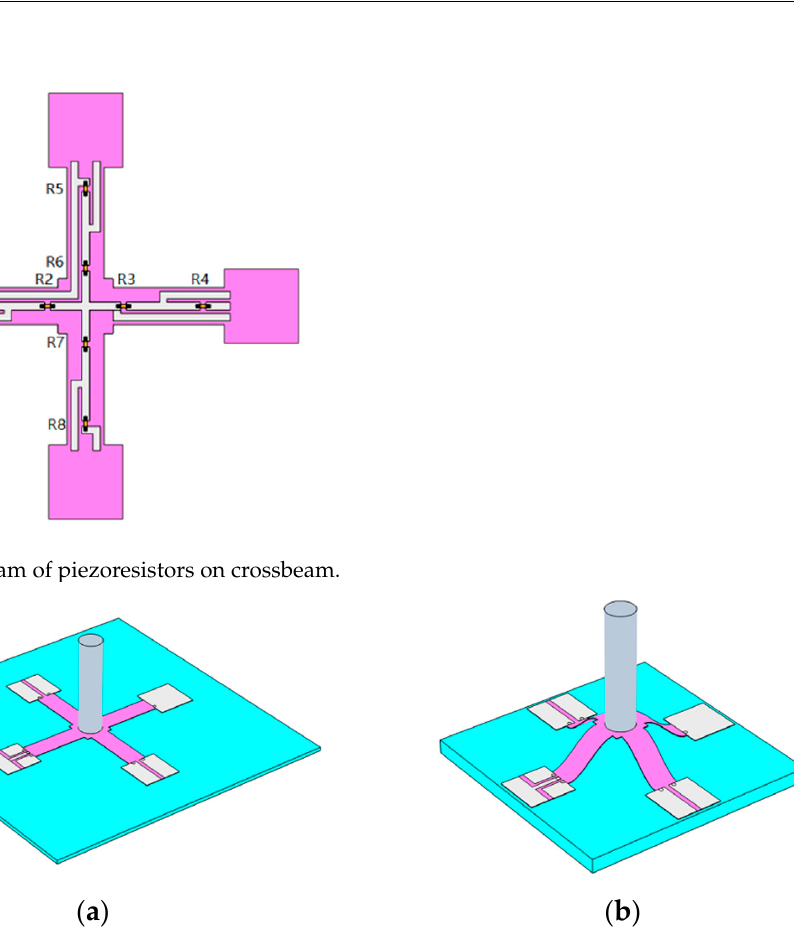
Figure 2. Structure on flexible substrate: ( a ) structure attached to stretched flexible substrate; ( b ) buckling structure on the released flexible substrate.